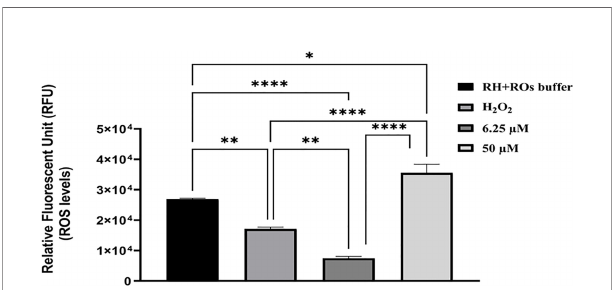
FIGURE 3 | DHQ caused elevated reactive oxygen species (ROS), in T. gondii (R-W strain) tachyzoites. To evaluate the effect of DHQ on T. gondii (RH-Wild type) tachyzoites reactive oxygen species (ROS) generation, extracellular parasites (1.60 x 10 6 parasites/50 m L) were puri fi ed by syringe and fi ltered using 3 m m fi lter. Next same parasites numbers were treated with DHQ concentrations of 6.25, 12.5 and 50 m M. Hydrogen peroxide (H 2 O 2 ) at 500 m M, and RH-ROs buffer were used as positive controls. Plates were incubated for 30 minutes followed by the addition of ROS dye and incubated for 45 minutes. Fluorescence were measured at 485 nm excitation and 563 nm emission. Data are presented as means plus standard errors of three different experiments performed in triplicate and analyzed using one-way ANOVA with comparison of means using Holm- Šı ́ dák multiple comparison with p < 0.05. * represent a signi fi cance difference between 50 m M and RH-ROs buffer (negative control) ( p < 0.004). ** indicates a signi fi cant difference between H 2 O 2 and 6.25 m M ( p < 0.004); **** indicates a signi fi cant difference between the following groups; H 2 O 2 and 50 m M ( p < 0.0001), 6.25 m M and 50 m M ( p < 0.0001), 6.25 m M and RH-ROs buffer group (p <